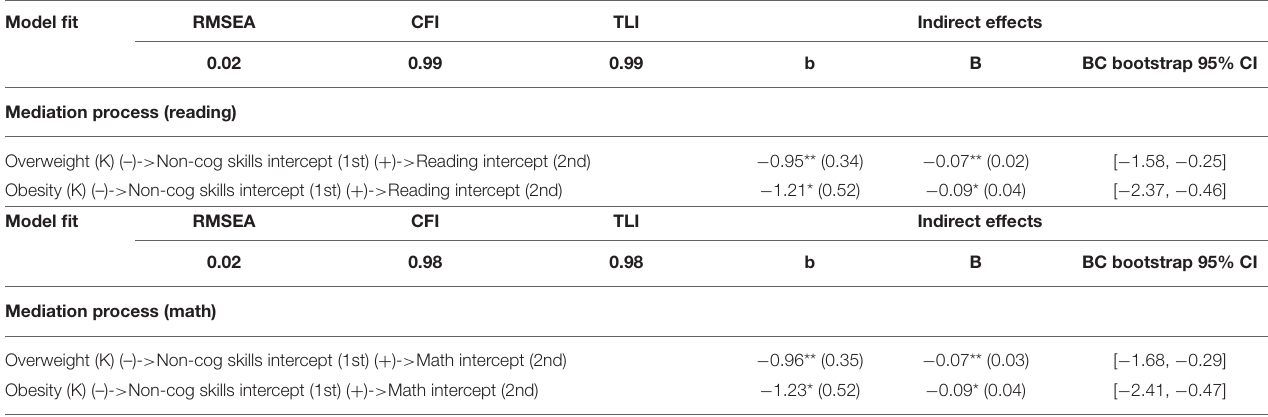
TABLE 3 | PP-LGM mediation model for girls ( n =